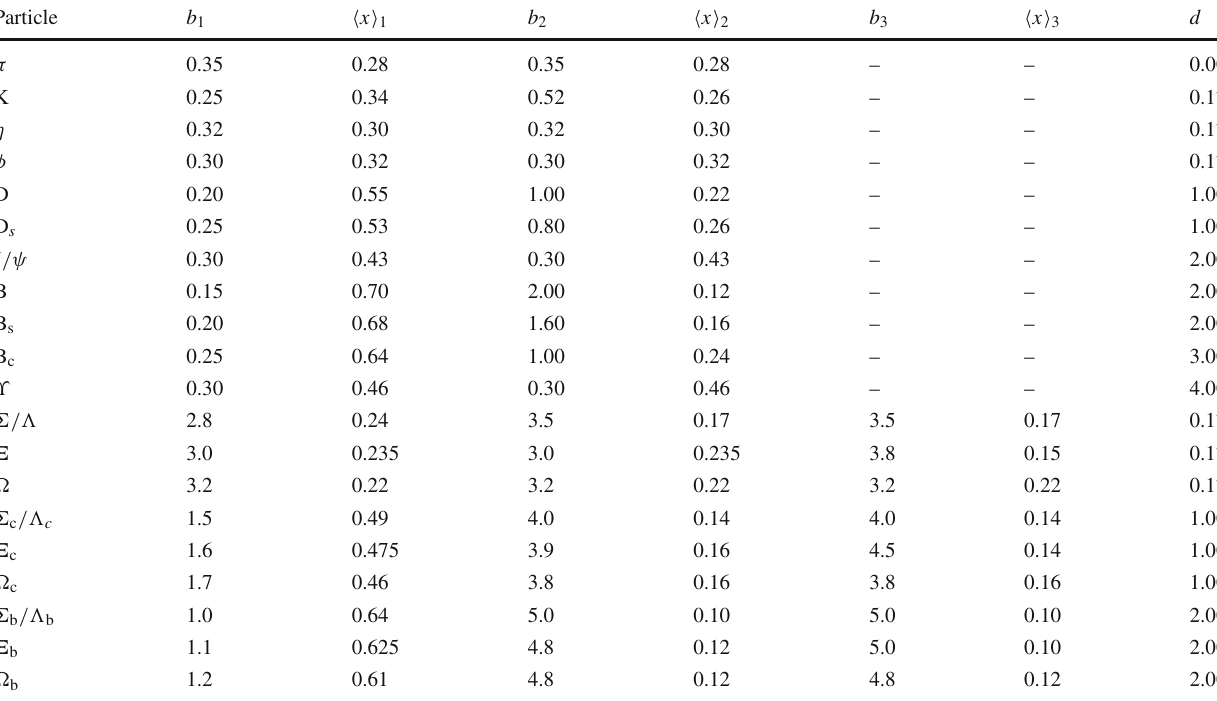
Table 3 Input parameters for the implemented hadron PDFs, as described in the text. Columns are ordered so that heavier quarks appear first. Excited hadrons are also implemented, using the same parameters as for a lighter hadron with the same flavour content Particle